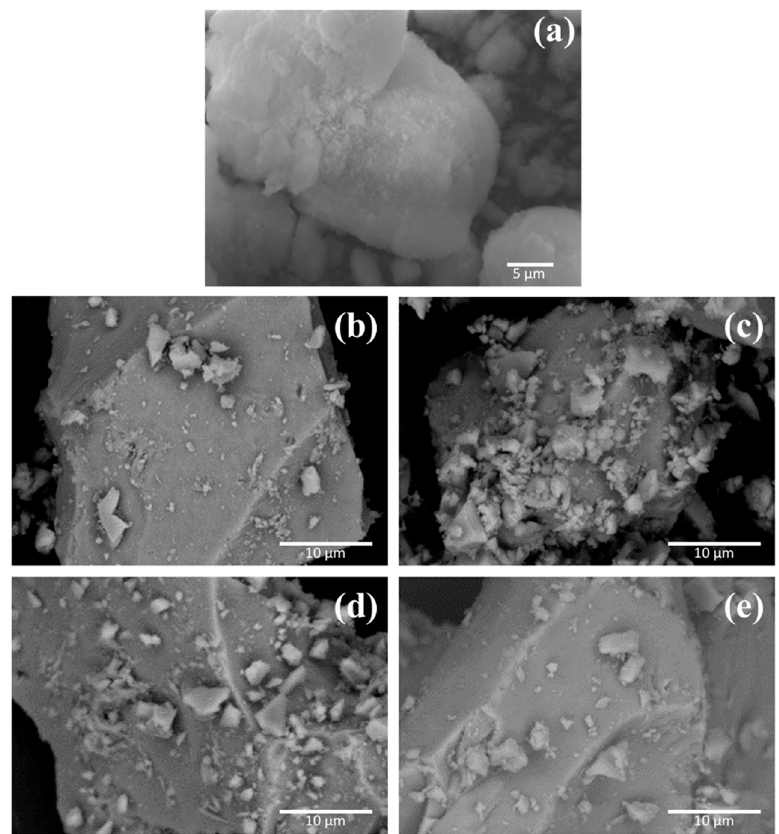
Figure 4. Scanning electron microscopy (SEM Quanta 250 FEI Company, Eindhoven, The Netherlands) images for samples: ( a ) ZrO2-RE1; ( b ) MxZy8La; ( c ) MxZy8Sm; ( d ) MxZy8Nd; and ( e ) MxZy8Gd.